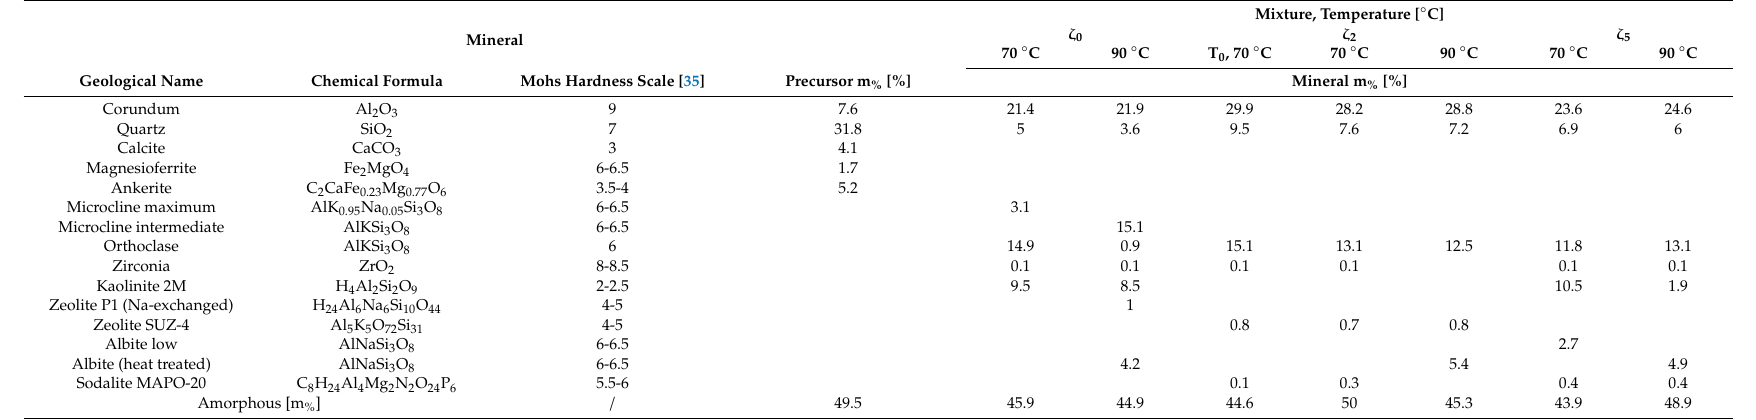
Table 6. Rietveld refinement results (m % of minerals and amorphous phase) of XRD measurements performed on precursor and one month old AAM synthesized using 50 g of mixtures ζ 0 , ζ 2 , and ζ 5 , cured first on room temperature (for 4 h) and then on 70 ◦ C (for 20 h), and for 24 h on 70 and 90 ◦ C. GOF is between 7.2 and 8.8.